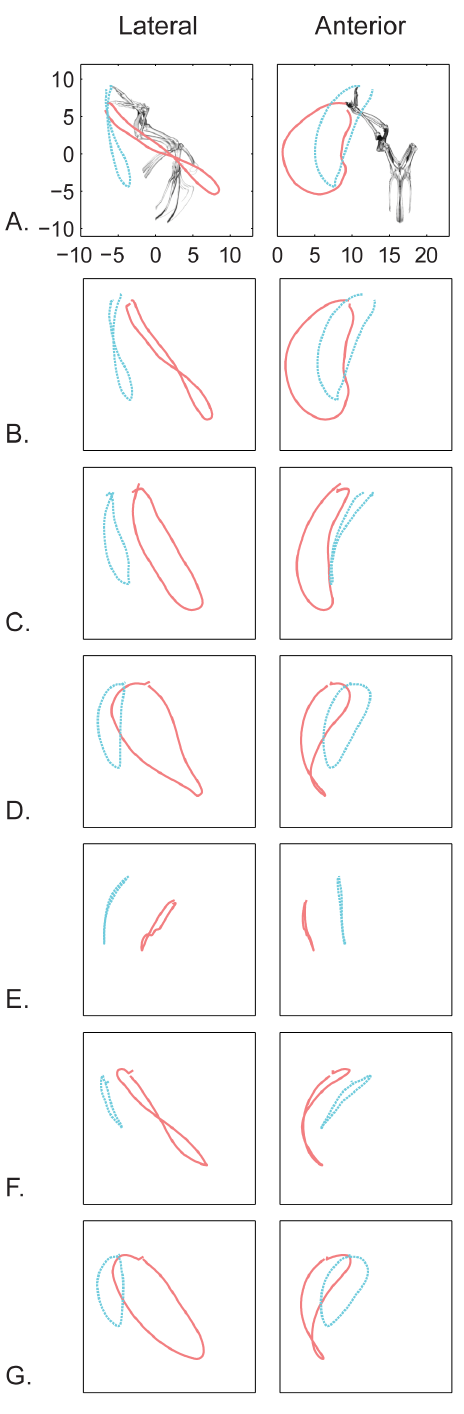
Figure 9. Joint contributions to fingertip path. A. wingtip path relative to the glenoid in a gravitational reference frame in lateral (left column) and anterior (right column) views for AF (red) and WAIR (blue). B – G show the paths after sequentially fixing one or more joints in their mean orientation and position throughout the complete wingbeat. B. pitch frozen. C. pitch and wrist motion frozen. D. pitch, wrist, and elbow motion frozen. E–G show the path after removal of each of the three degrees of freedom independently from glenohumeral motion. E. elevation/depression removed. F. protraction/retraction removed G. pronation/supination